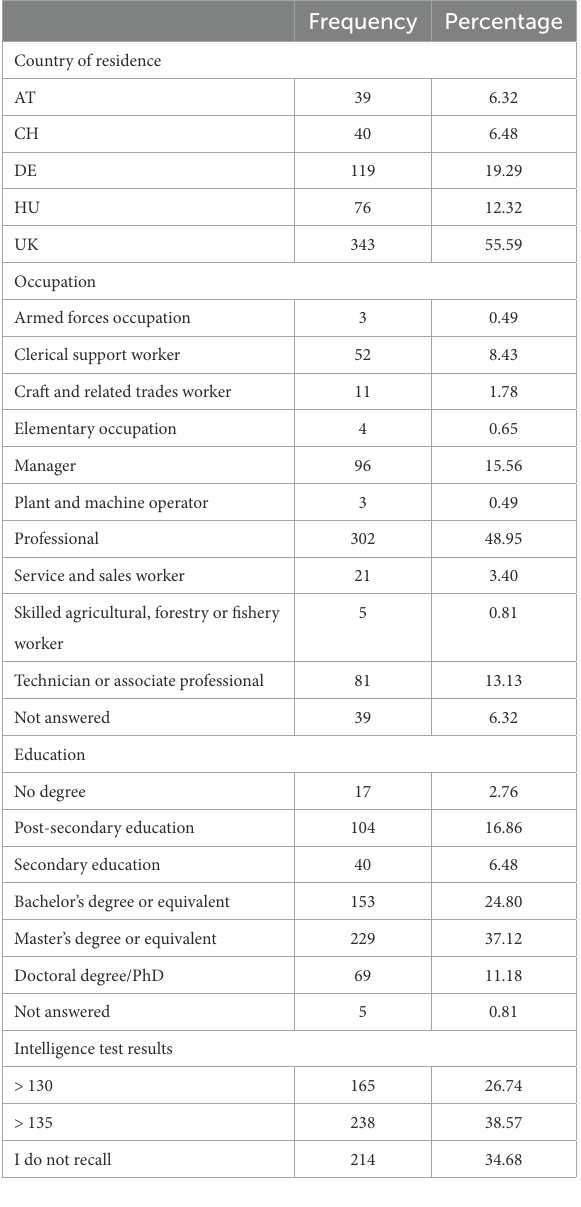
TABLE 2 Frequencies for sociodemographic